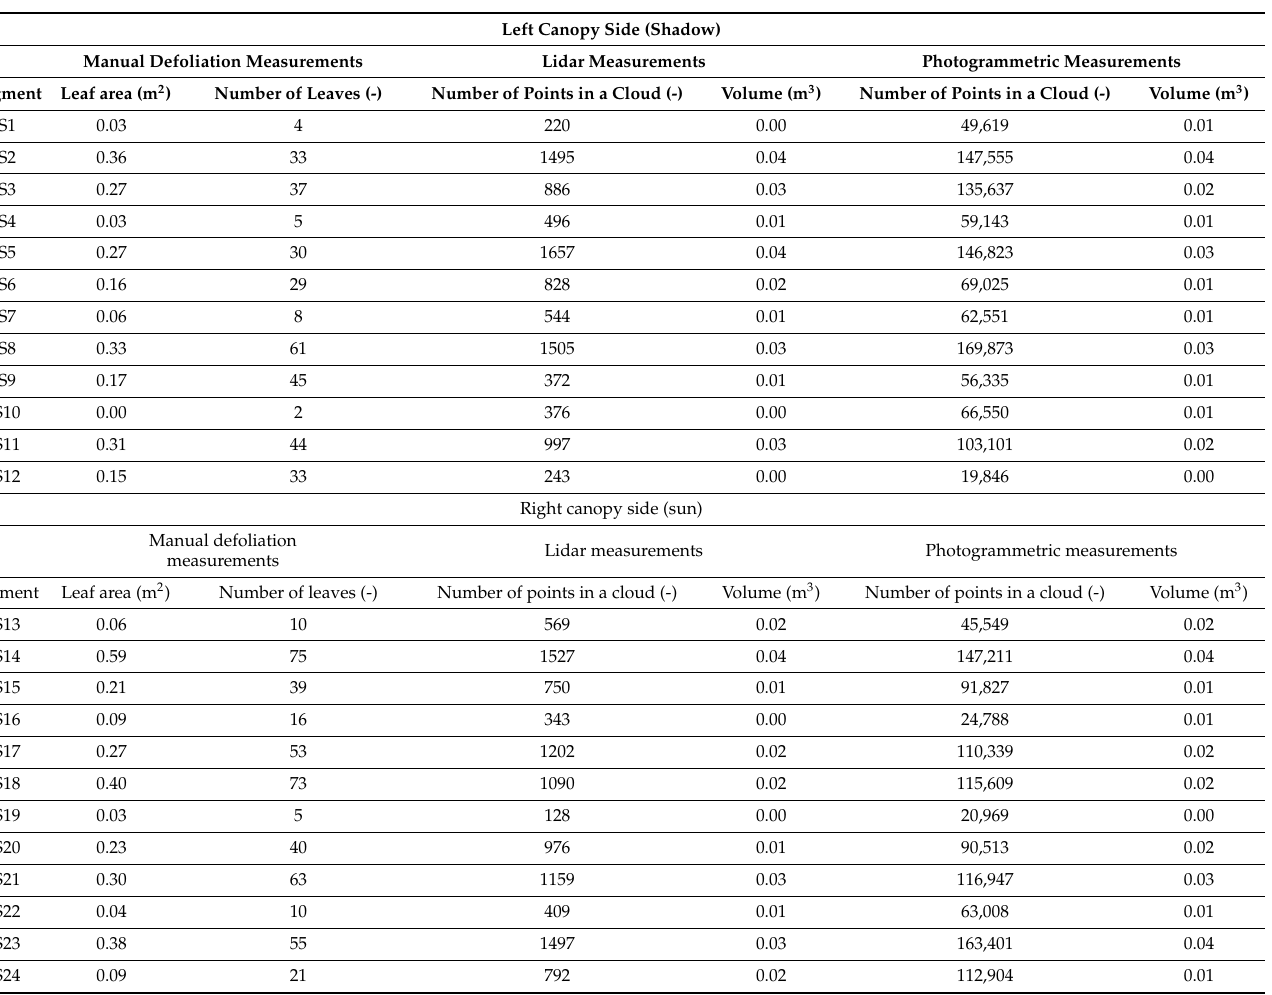
Table 2. Results of terrestrial lidar, UAS photogrammetry, and manual measurements for the left and right halves of the vine